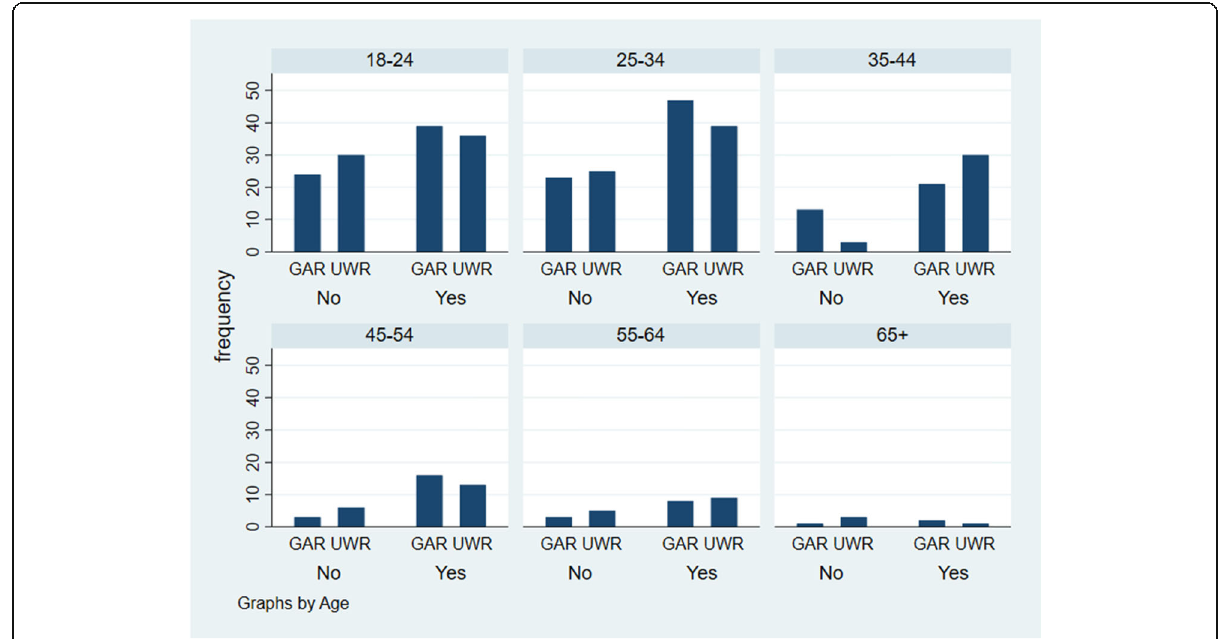
Fig. 2 Appropriate antibiotic use by age and region